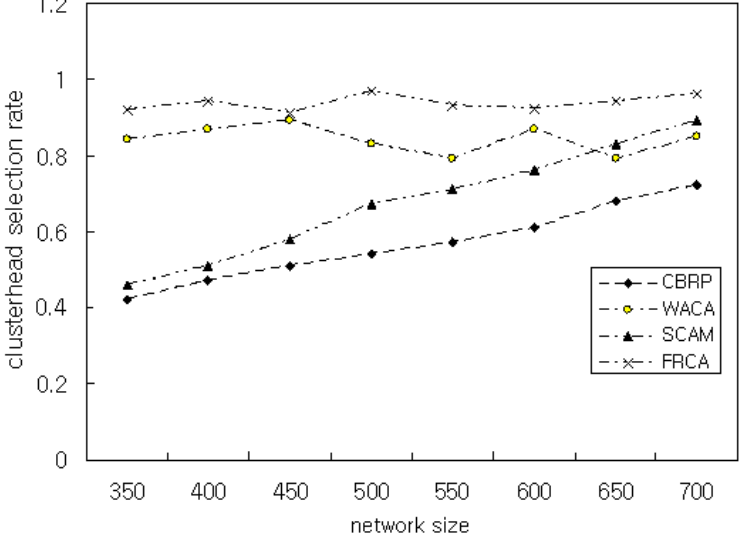
Figure 9. Clusterhead Selection Ratio with Network Size 700 and  = 0.9.